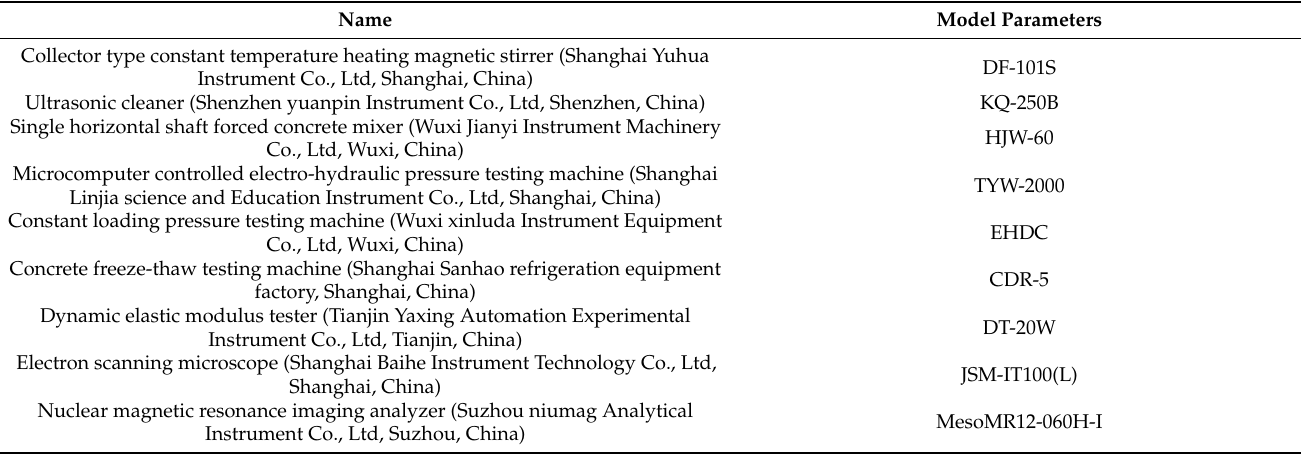
Table 4. Main test